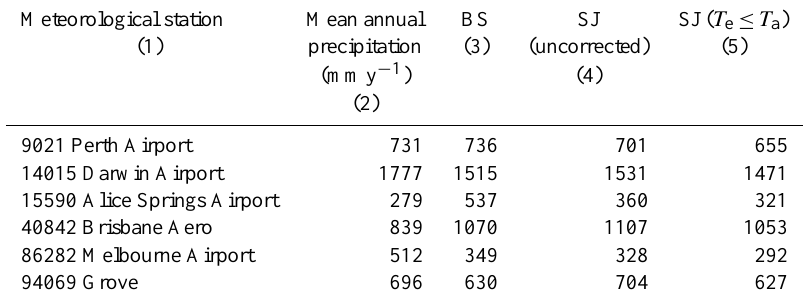
Table 1. Comparison of the Szilagyi–Jozsa (SJ) advection–aridity actual evapotranspiration model incorporating T e ≤ T a with uncorrected SJ and with the Brutsaert–Stricker (BS) advection–aridity